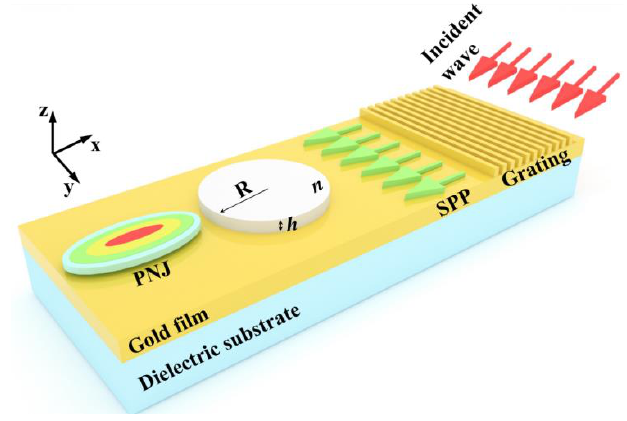
Figure 1. Schematic diagram of a PJ formed by a gold − film dielectric microdisk structure.